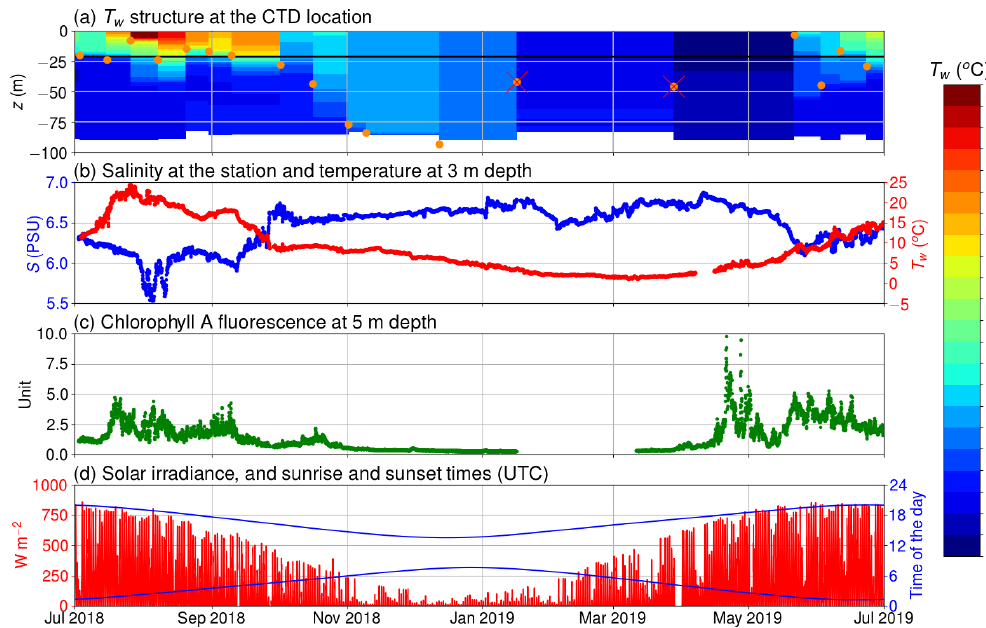
Figure 2. (a) The temperature of the seawater ( T w ) assessed by the CTD casts and the depth of thermocline (orange circles); discarded thermocline depths are marked with a red cross; the horizontal black line depicts the depth of the inlet; (b) salinity at 5m depth and temperature at 3m depth; (c) chlorophyll a relative fluorescence at 5m depth; (d) solar irradiance (in red) and sunrise and sunset times (in blue) in UTC.